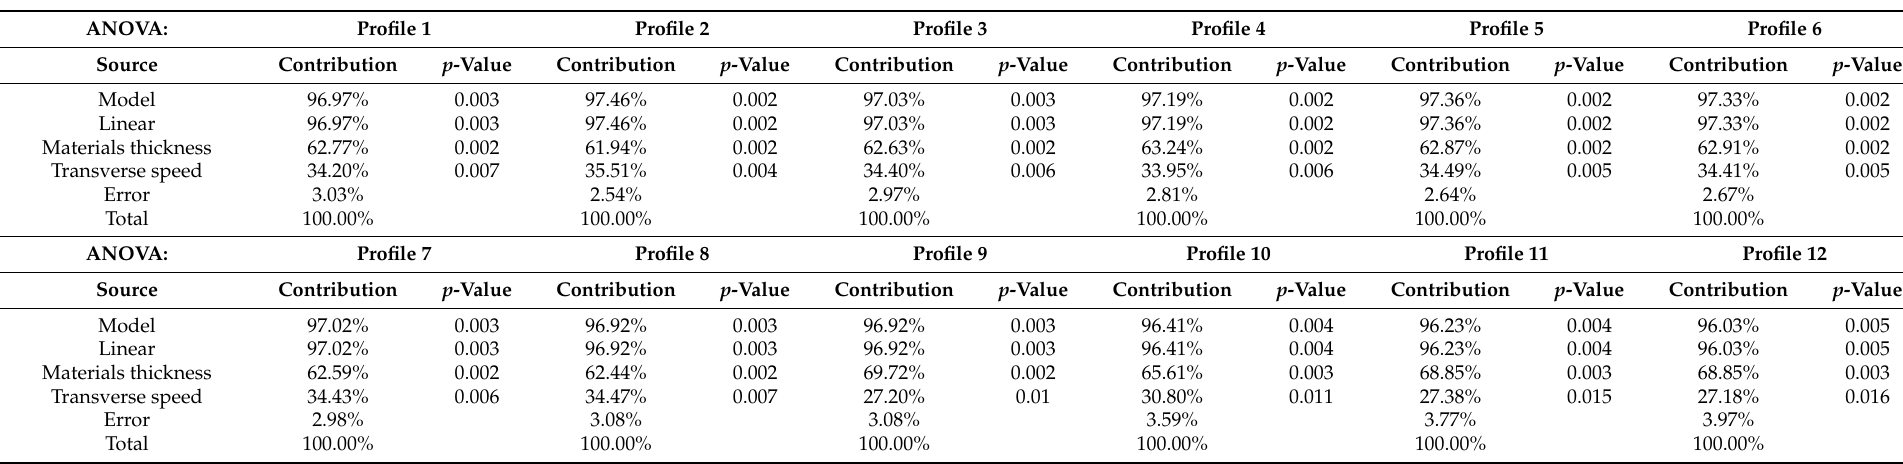
Table A3. Analysis of variance of material removal